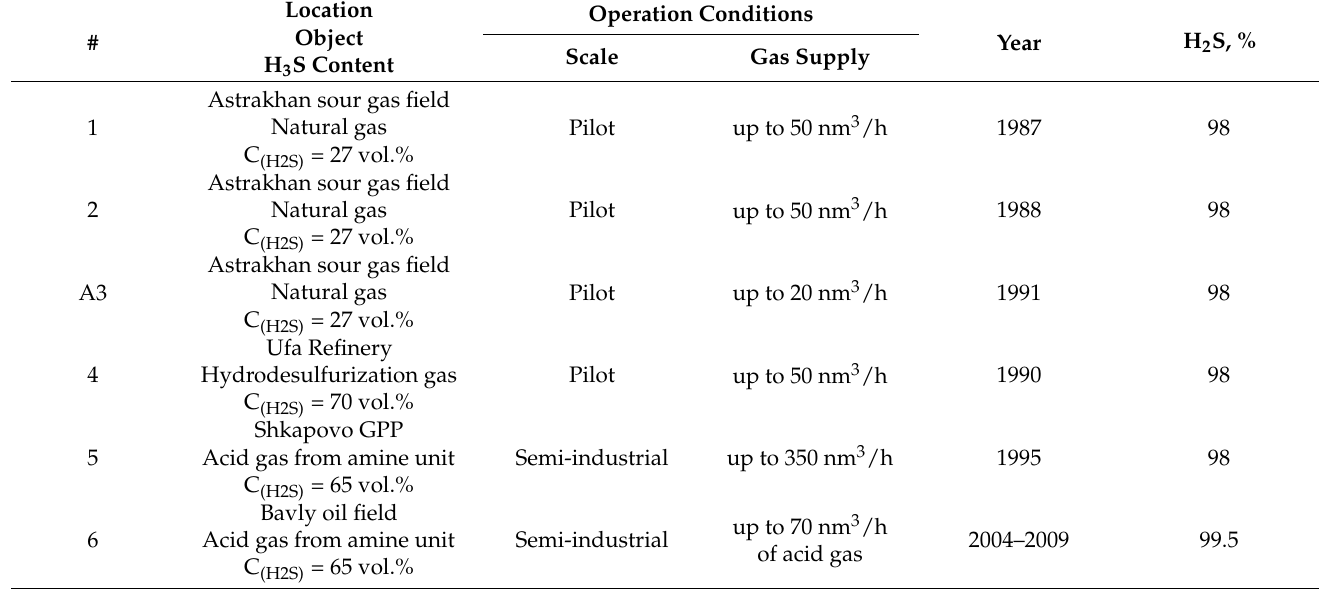
Table 2. Pilot and experimental industrial tests of the technology of direct catalytic oxidation of hydrogen sulfide (Modifica- tion 1-fluidized bed)